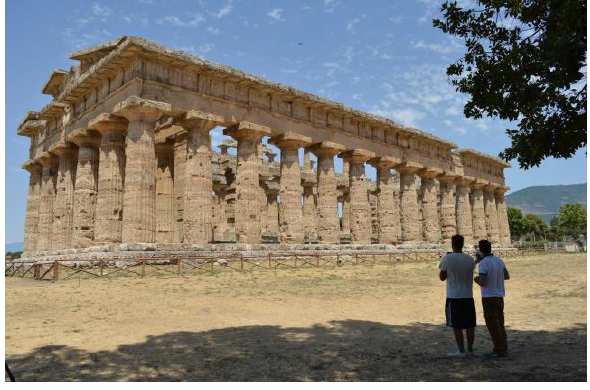
Figure 1 . Photogrammetric survey phase.